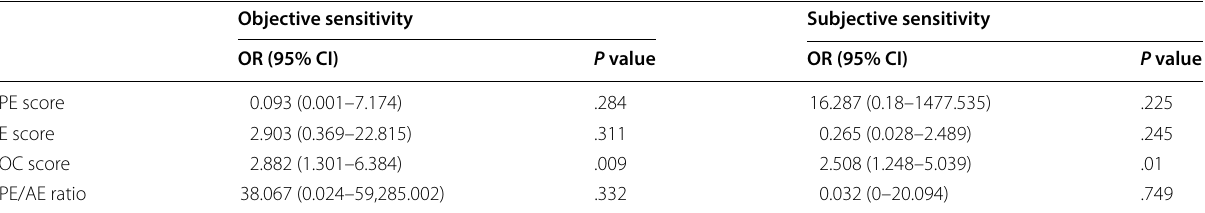
Table 3 Multivariate logistic regression analysis of the predictive factors for GC